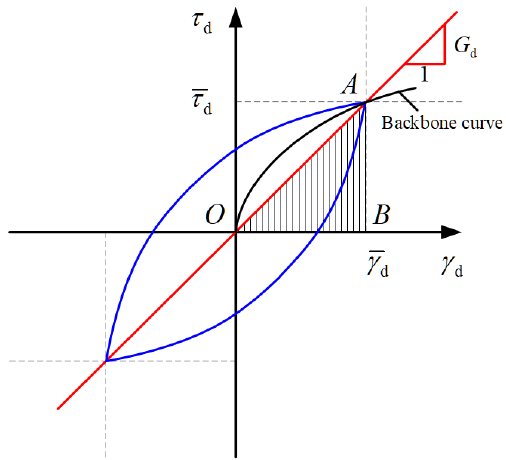
Figure 4. Determination of dynamic soil properties.